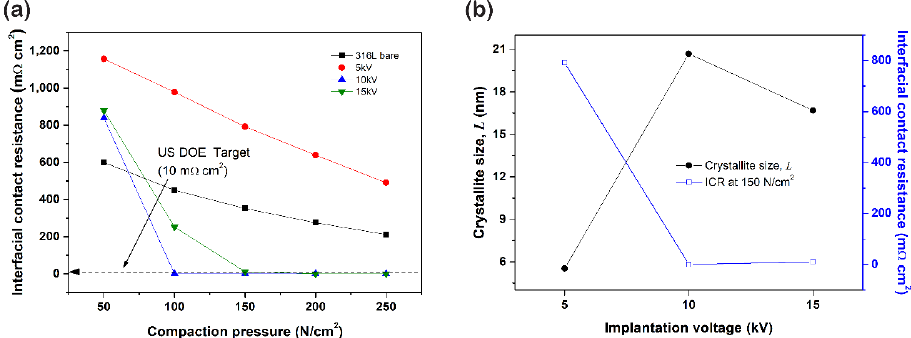
Figure 8. ( a ) Interfacial contact resistance (ICR) and ( b ) correlation between ICR and crystallite size of N + -implanted samples.